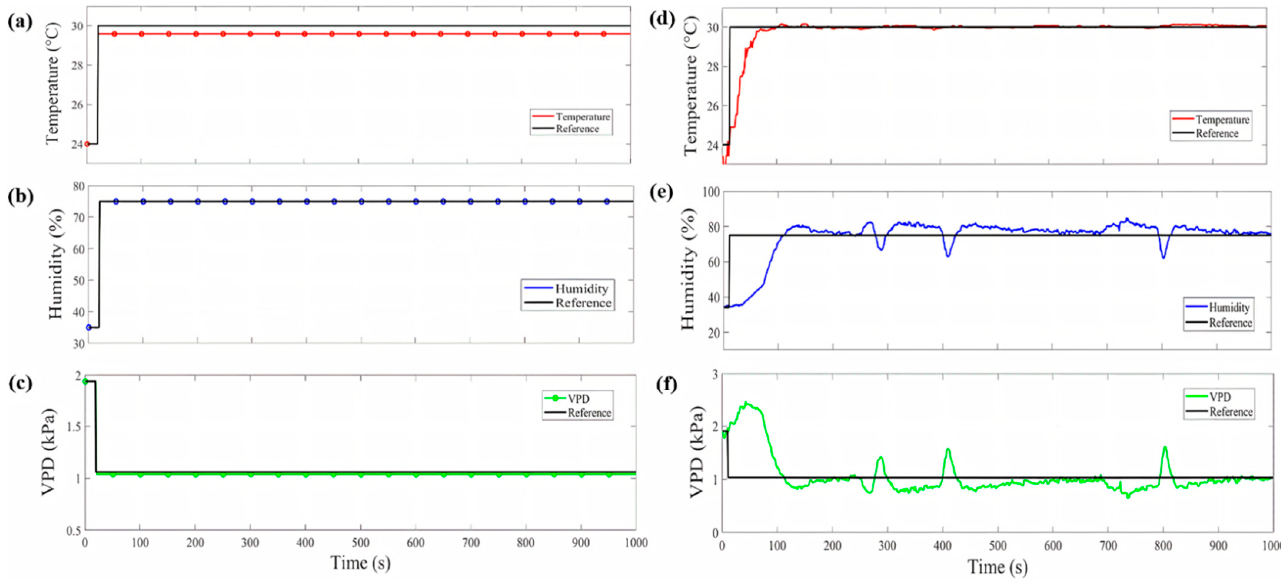
Figure 5. Simulation ( a – c ) and implementation ( d – f ) graphs of temperature FL control, humidity NN control and VPD control. Table 4. Error comparison in simulation and implementation.